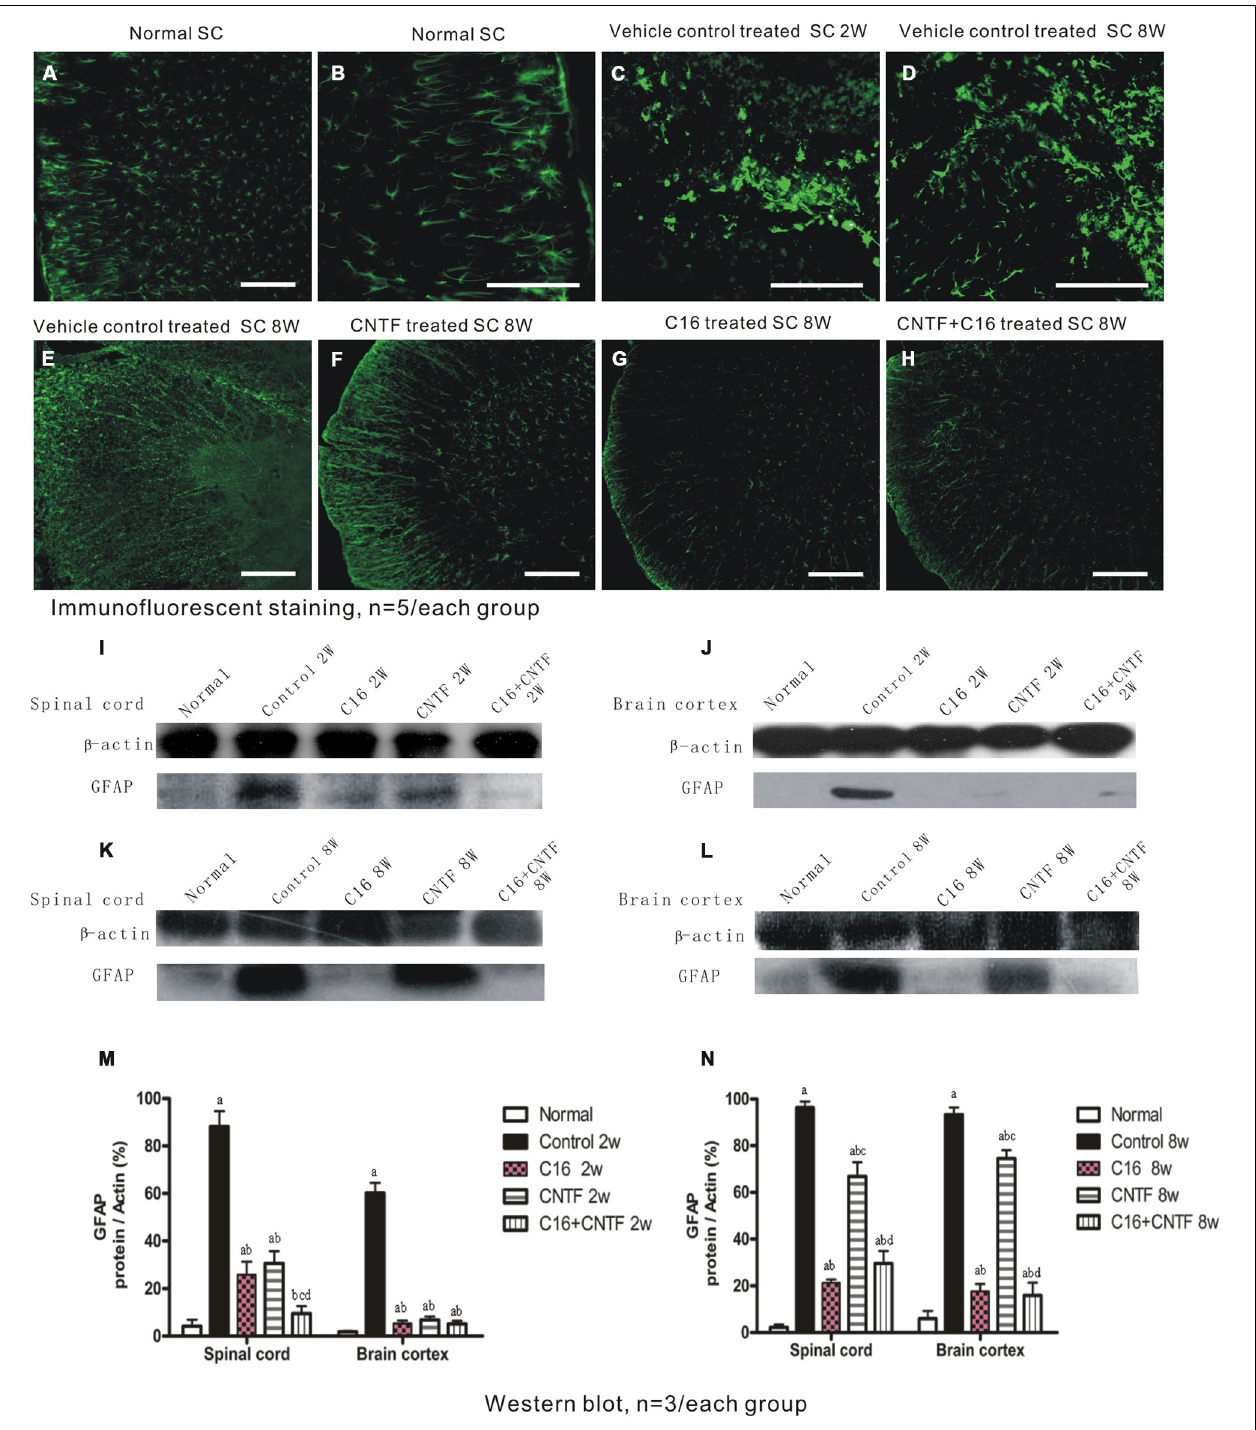
FIGURE 9 |Treatment with CNTF or C16 inhibited reactive gliosis, as revealed by FITC-conjugated GFAP immunofluorescent staining (traverse sections through the lumbar spinal cord), bar = 100 μ m. At week 2 post-immunization; (A) normal control group, (B) enlarged image showed the normal astrocytes. (C,D) Vehicle-treated EAE rats, showing astrocyte proliferation and formation of a visible glial scar (in (C) ]. At week 8 post-immunization, vehicle-treated EAE rats (E) and CNTF-treated EAE rats